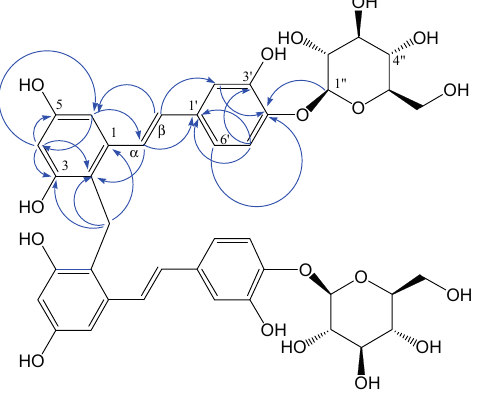
Table 1. 1 H, 13 C-NMR and HMBC (500M Hz) data of 1 (CD